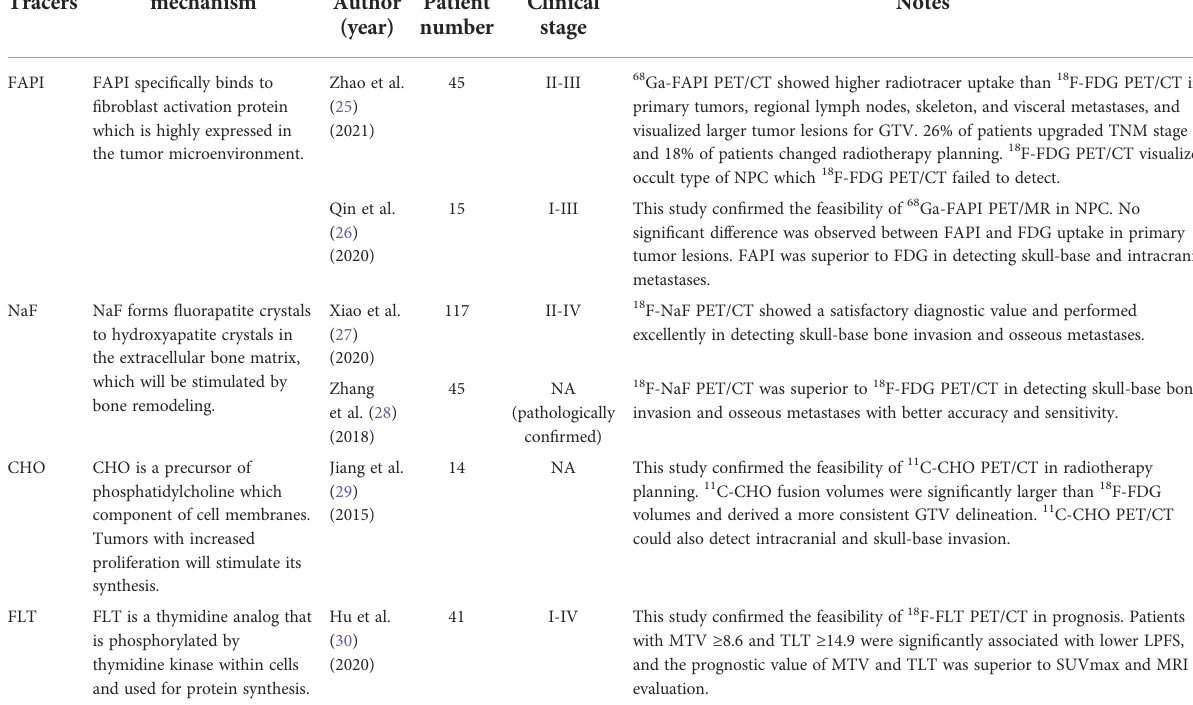
TABLE 2 Critical studies investigating novel PET radiotracers in NPC. Tracers